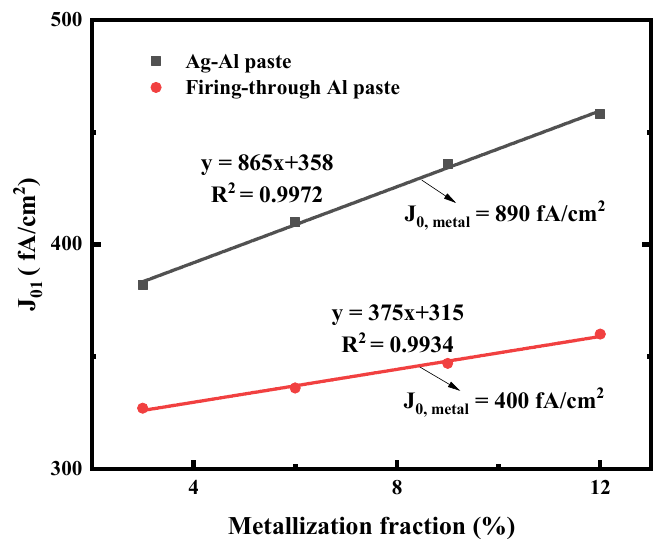
Figure 5. J 01 extracted from Suns-V OC as a function of metal fraction variation on the cell boron emitter. The J 0, metal is then extracted from the linear fit (solid lines).